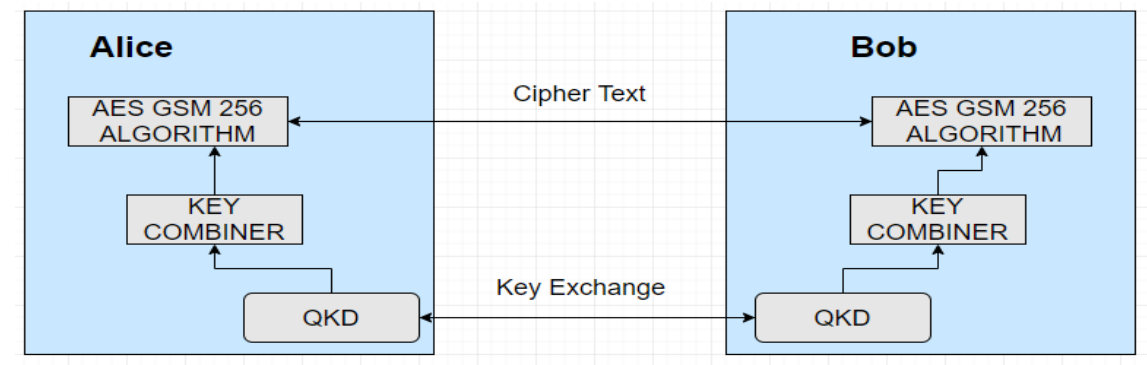
Figure 4. Communication Mechanism in Encryption